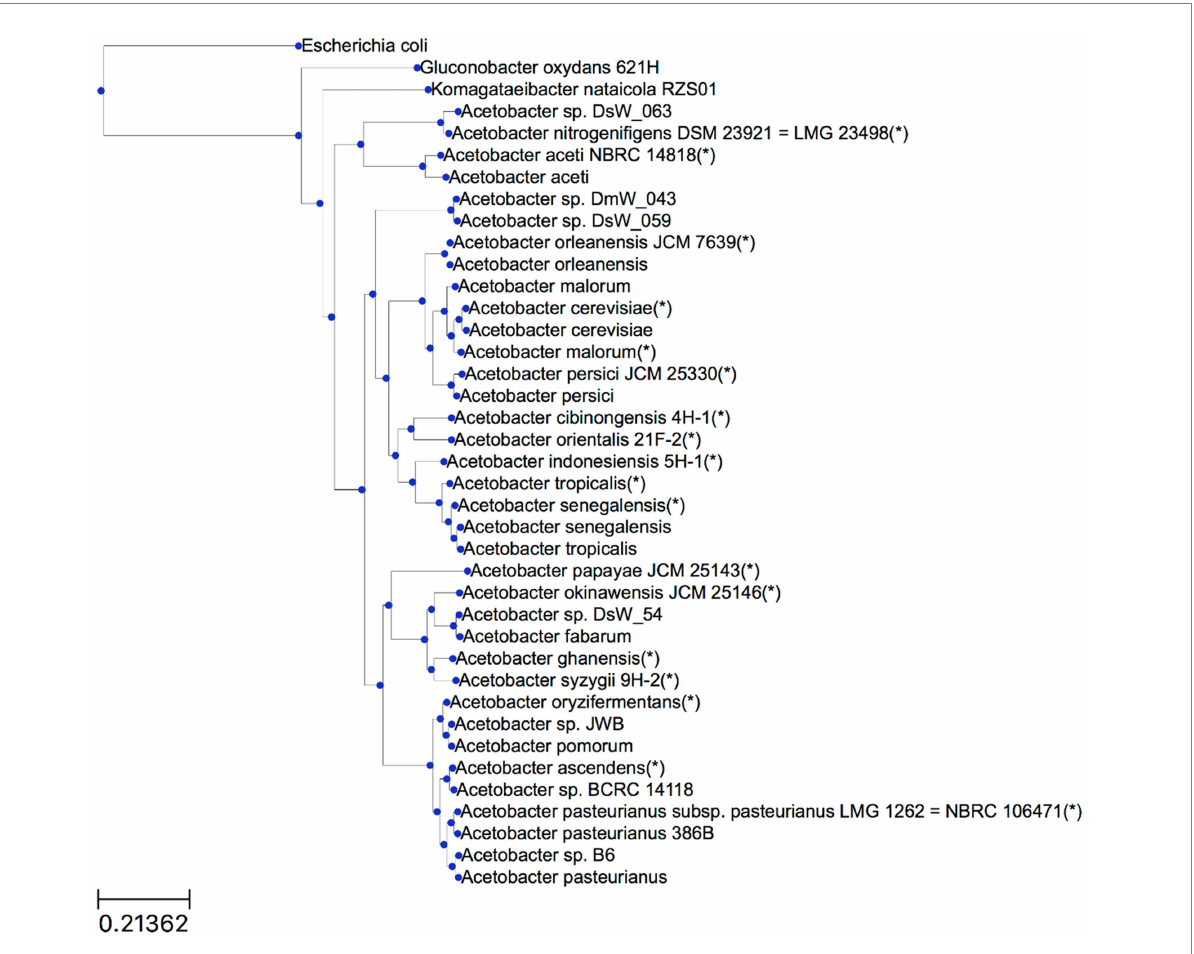
FIGURE 1 Rooted species tree inference by OrthoFinder. Branch lengths represent the average number of substitutions per site. Type strain genomes are indicated with an asterisk (*). For genomes for which the strain name is not indicated, the reader is referred to Table